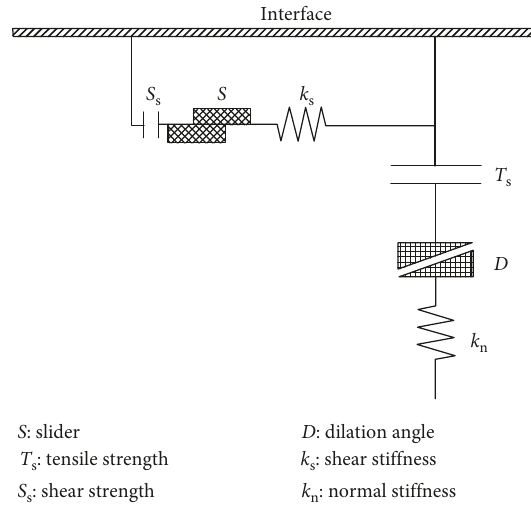
Figure 16: Schematic diagram of the practical interface